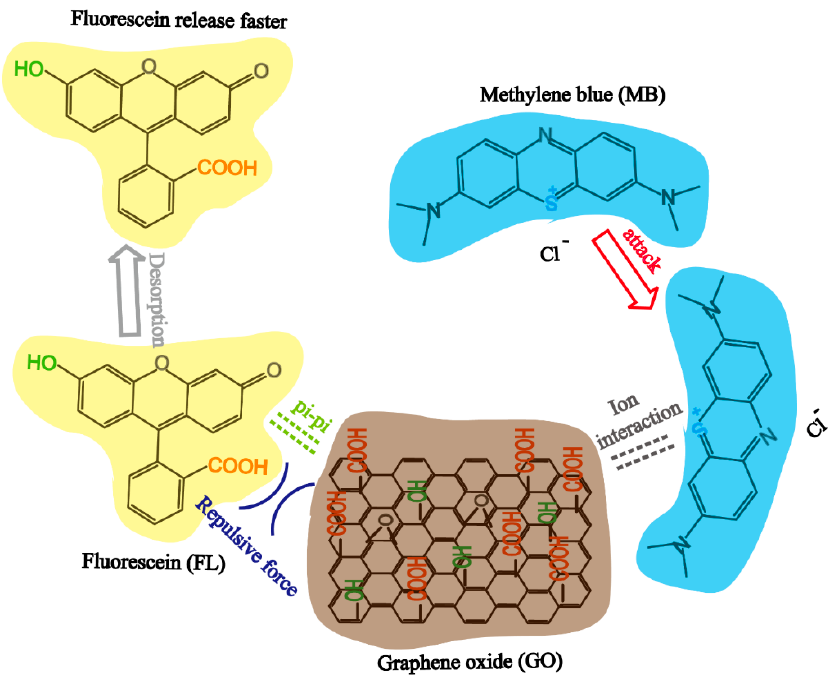
Figure 7. The interaction mechanism of GO, MB, and FL.